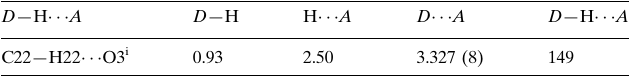
Hydrogen-bond geometry (A˚ , (cid:2)